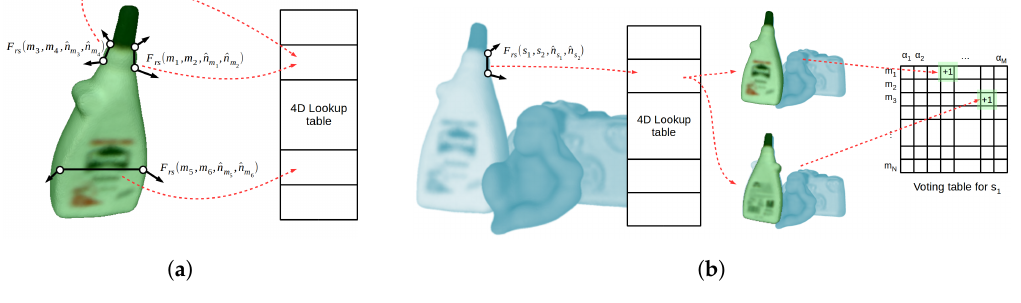
Figure 2. Representation of the modeling and matching steps of the Point Pair Features voting method. ( a ) modeling example for three point pairs from the model; ( b ) matching example for one point pair from the